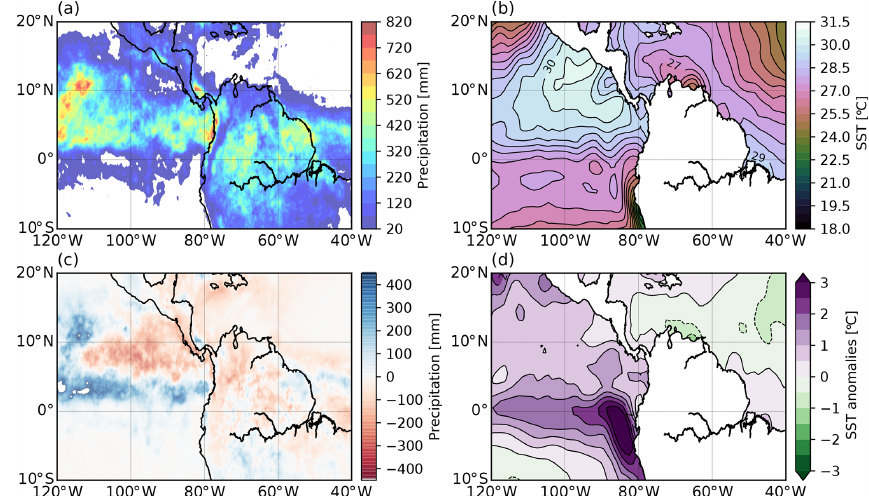
Figure 5. (a) Regional cumulative precipitation from the TRMM 3B42 product (blue-to-red shading) and mean SST (green-to-white shading and black lines) during May 2015. (b) Cumulative precipitation (red-to-white shading) and mean SST (green-to-purple shading and black lines) anomalies relative to the long-term May conditions. Temperature contours are every 0.5 ◦